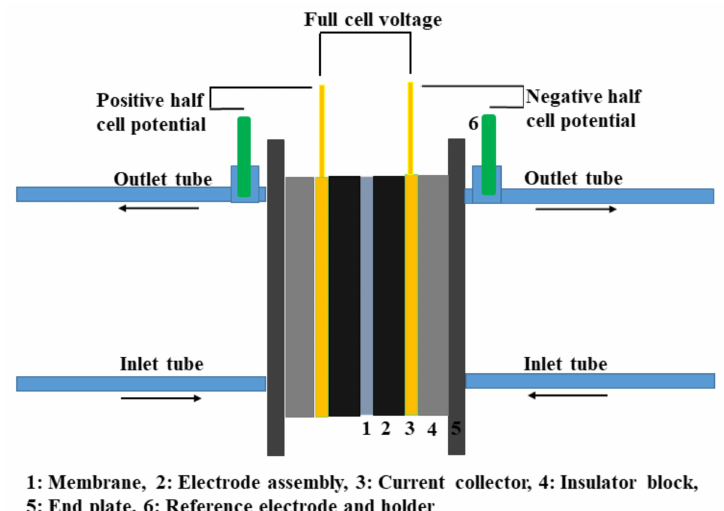
Figure 6. Schematic diagram for half-cell potential measurement.